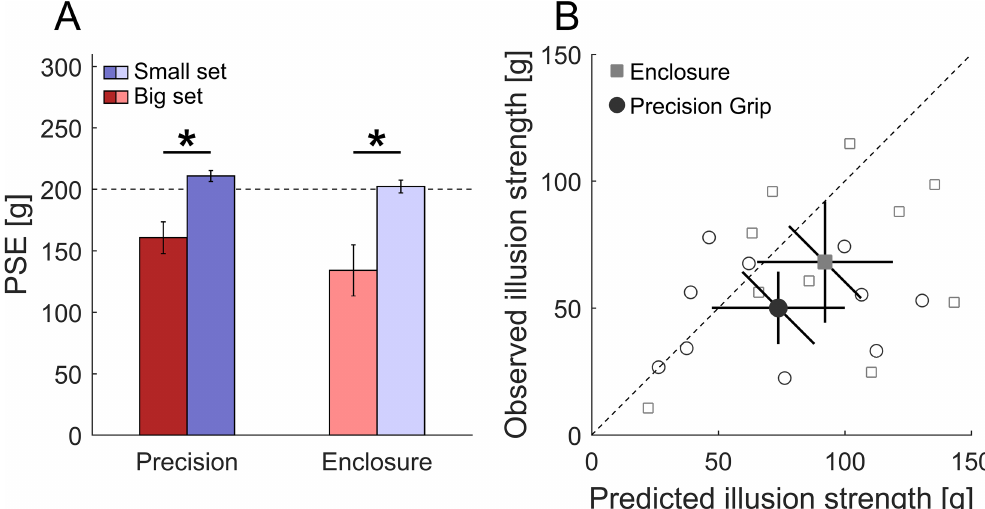
Fig 6. Main results of Experiment 3. (A) Average PSE values for the small (purple) and the big set (red) with 95% confidence intervals. (B) Observed against predicted illusion strength for both grip types. Lighter gray squares indicate the enclosure condition. Open symbols denote individuals. Diagonal error bars for the aggregated data mark the error of the differences between observed and predicted values and have to be compared to the identity line.